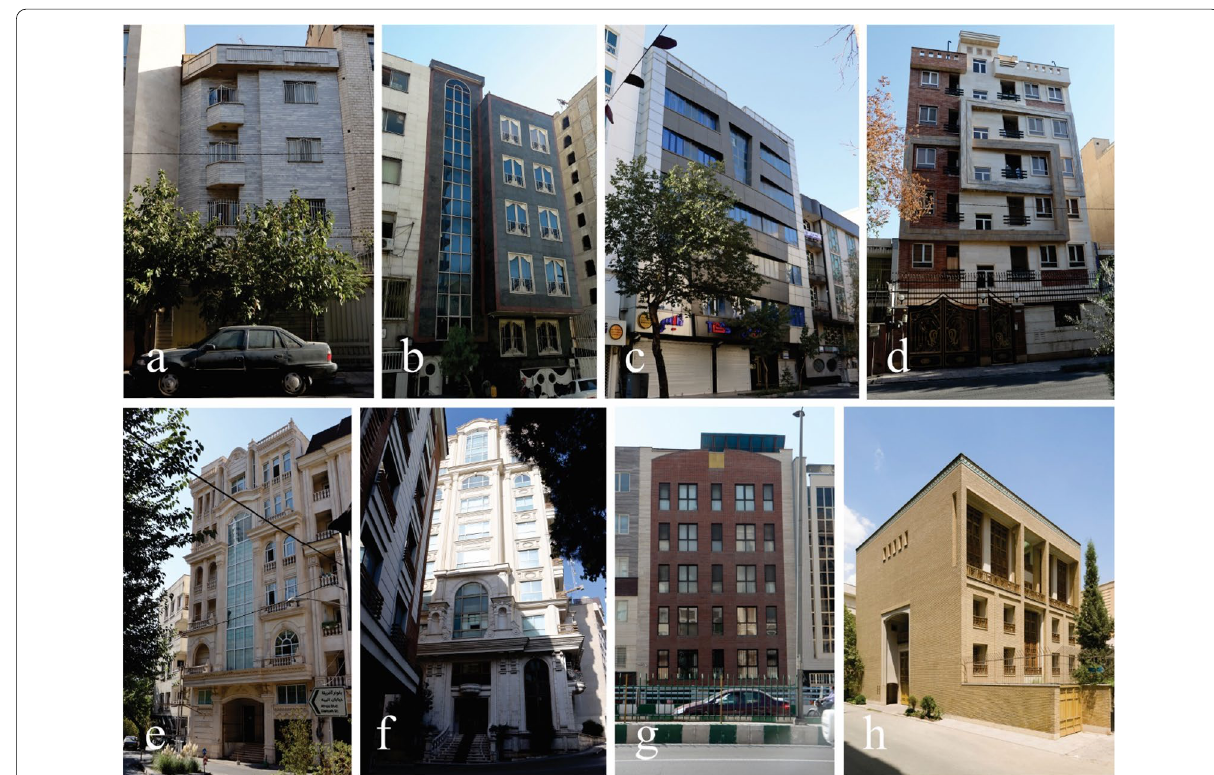
Fig. 9 Urban facades of Islamic Republic period in Tehran; a Jafarzadeh, Shariati St; b Shariati St; c Golnabi St; d Jafarzadeh, Shariati St; e Shabdiz St; f